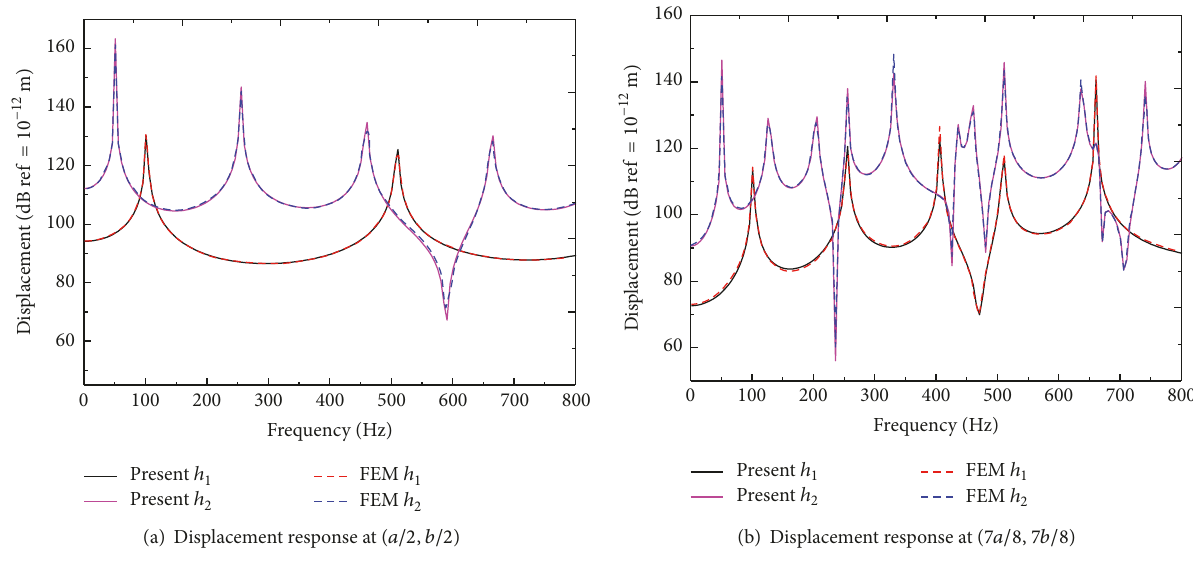
Figure 5: Vibration displacement response of the simple support isotropic plate with varying